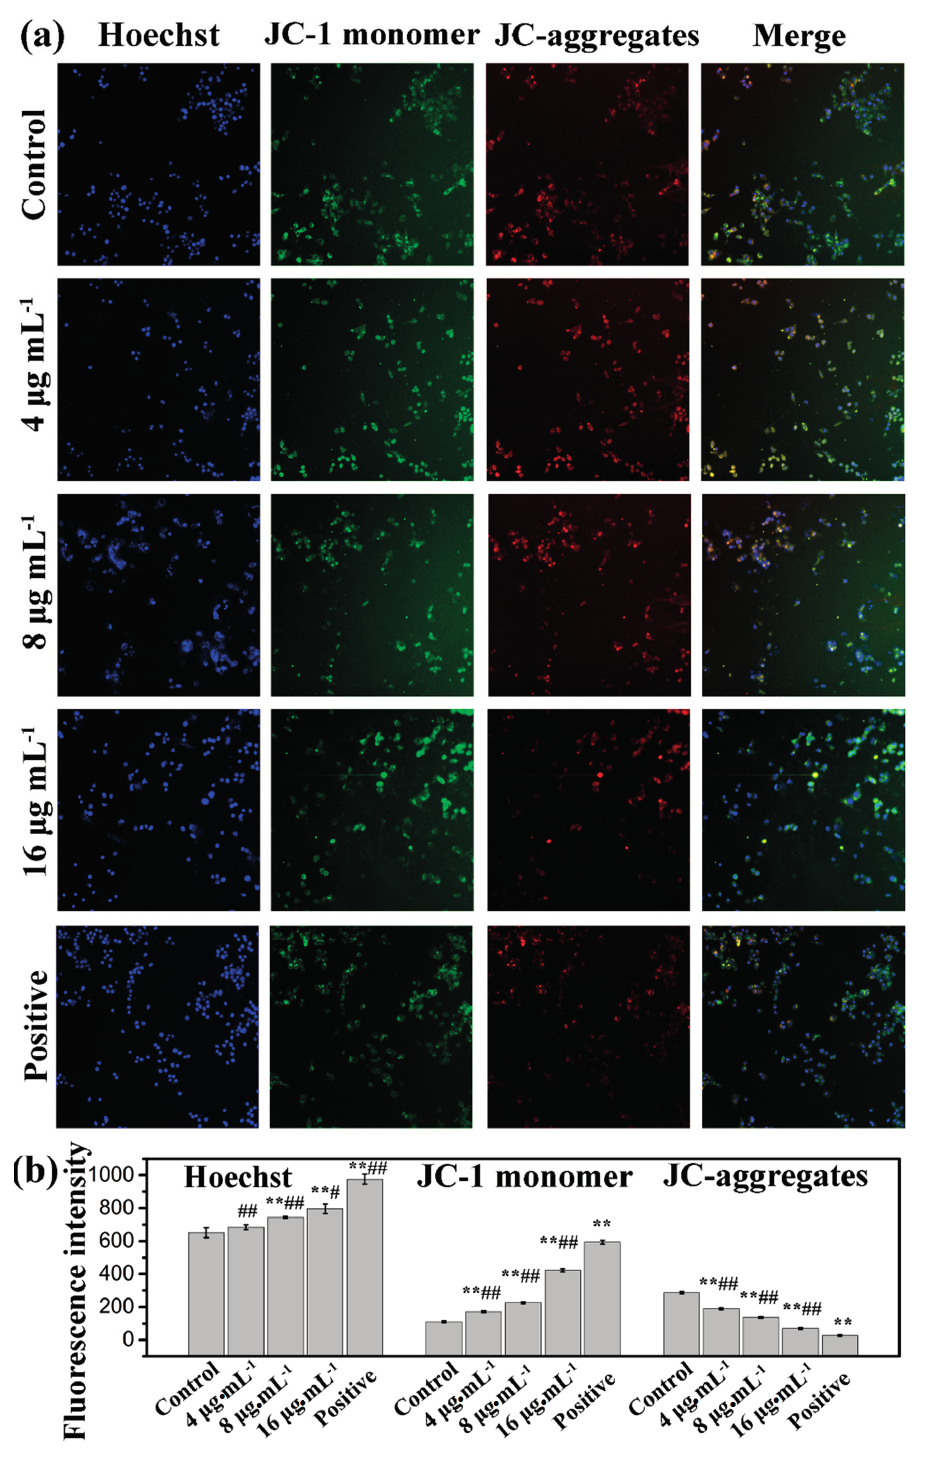
Figure 8. Mitochondrial membrane potential detection by high content screening (HCS) after treatment with kansenone for 48 h under a magnification of 100. Compared with corresponding control group, ** p < 0.01; Compared with corresponding positive control group, # p < 0.05, ## p <